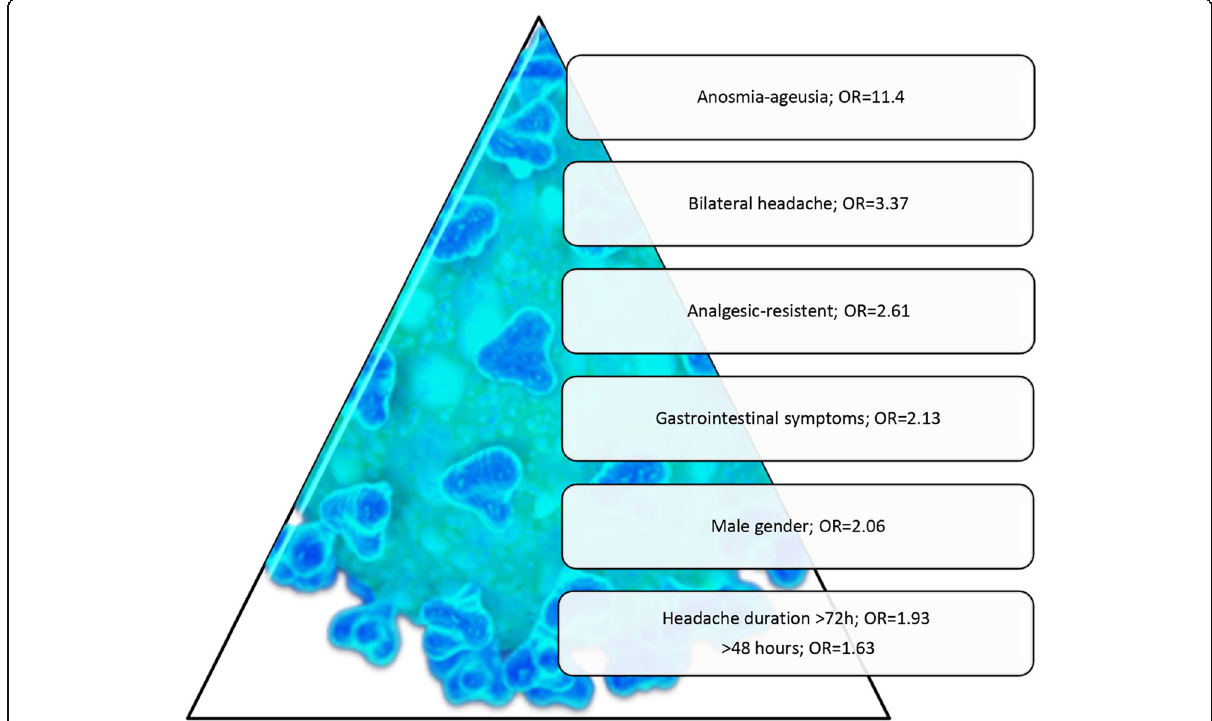
Fig. 4 Odds ratios of differentiating variables related to the presence of headache in patients with COVID-19 diagnosis reporting headache during the